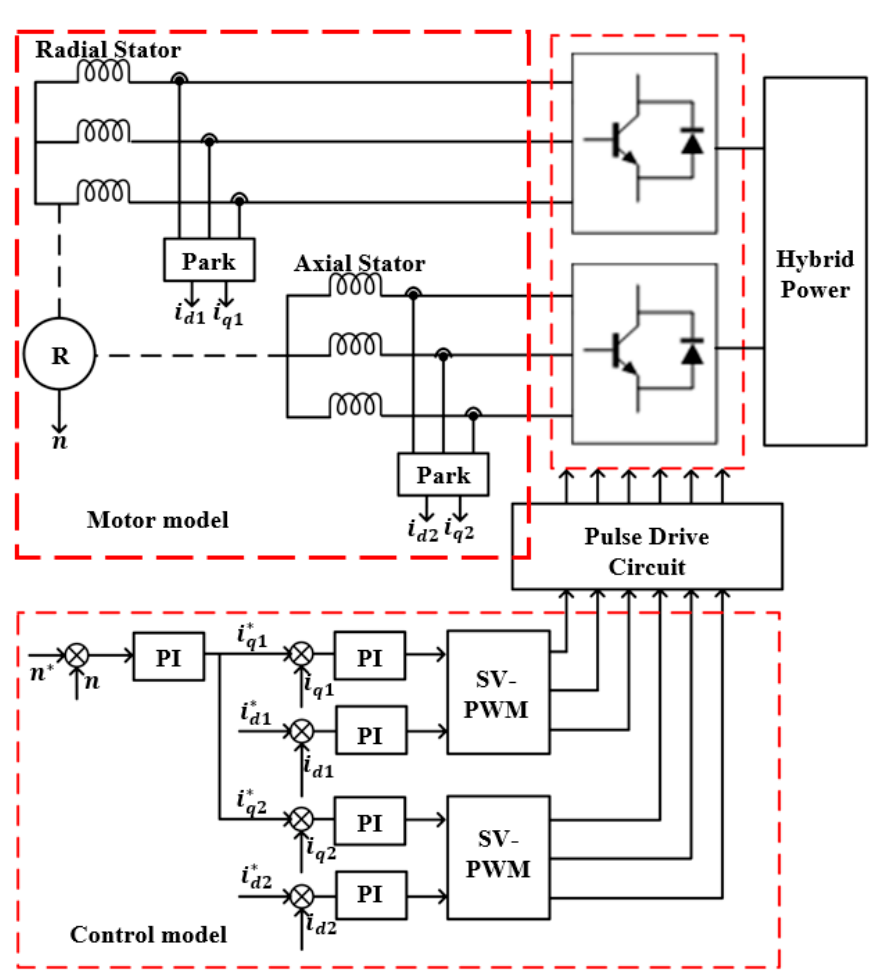
Figure 4. Simulation model in driving mode.